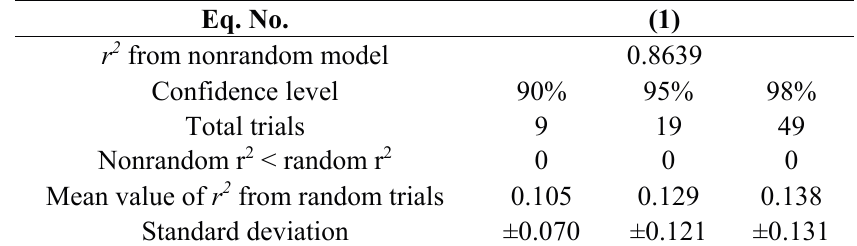
Table 5. Randomization test of genetic function approximation (GFA)